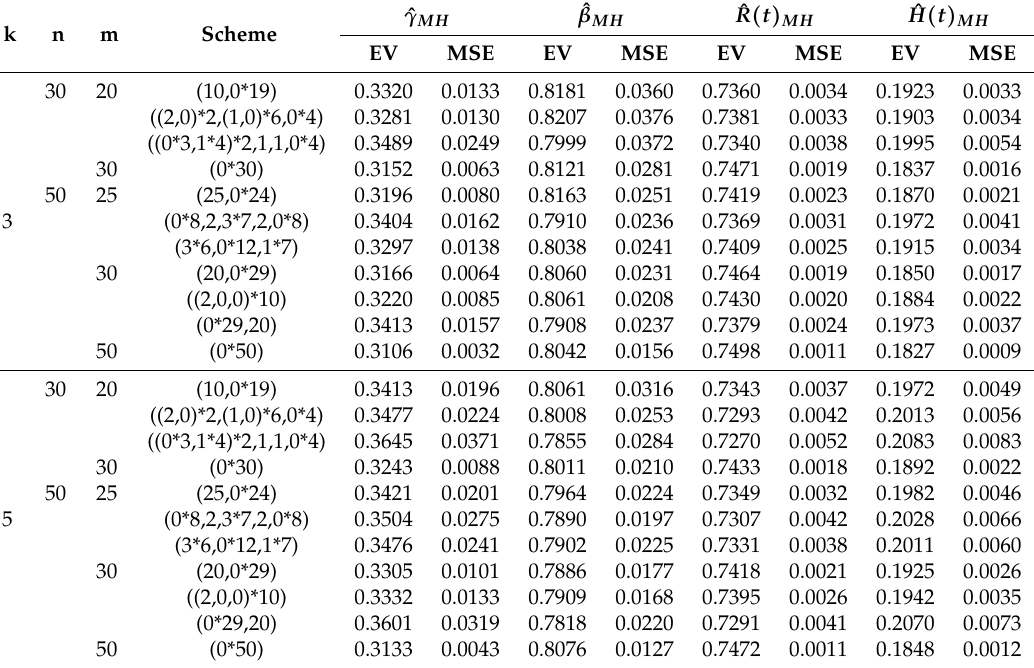
Table 17. Estimation values and MSEs of parameters, reliability and hazard functions using Metropolis-Hastings method under GELF when q = 0.5, γ = 0.3, β = 0.8, t = 1.5, a 1 =